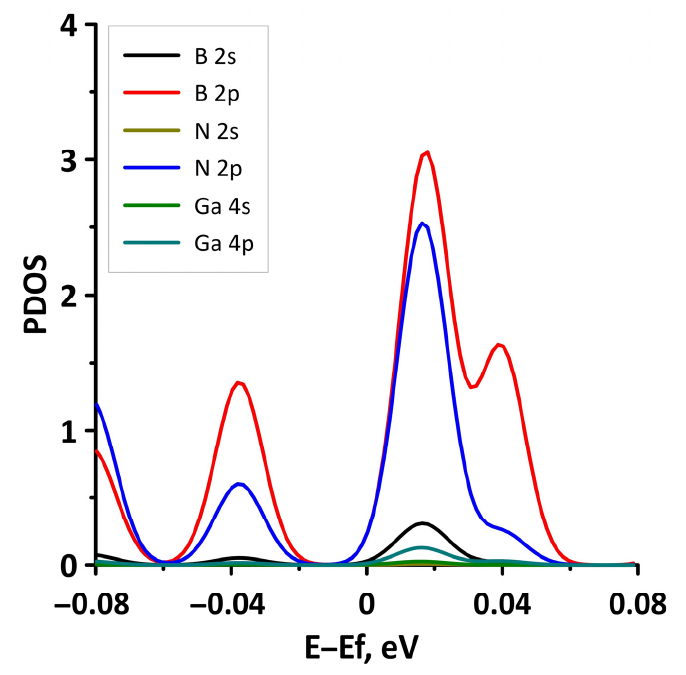
Figure 22. Fragments of PDOS near the Fermi level (shifted to 0 eV) of borophene/GaN heterostruc- ture under biaxial stretching by 6%.